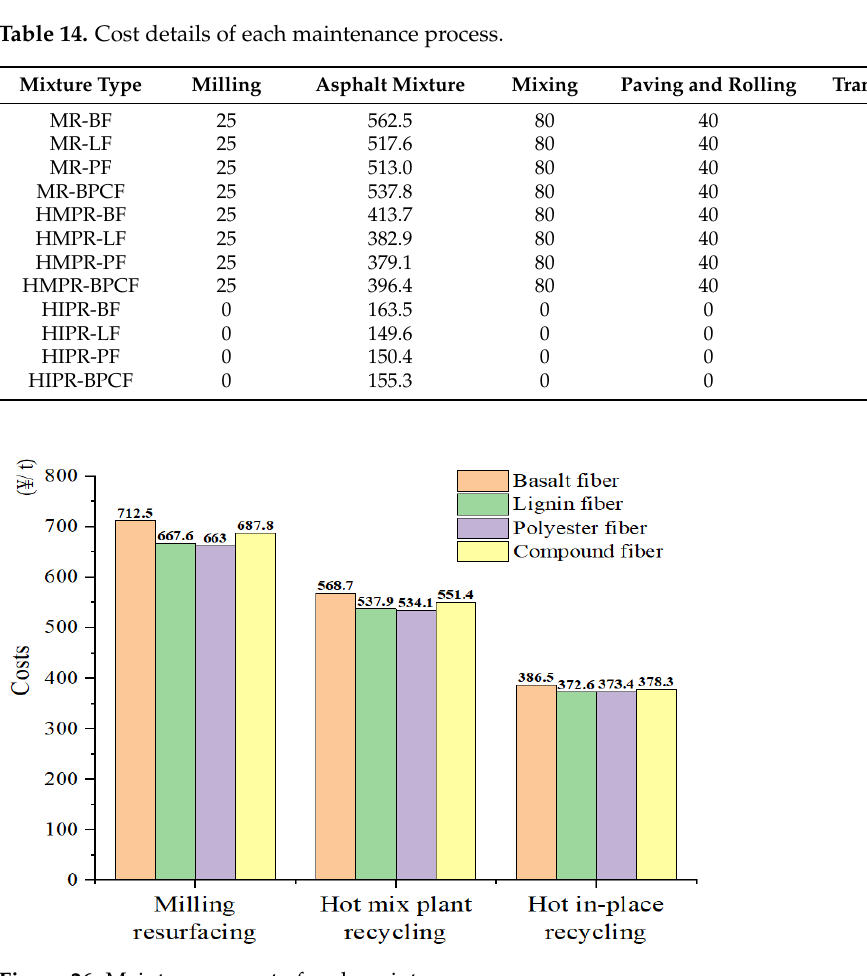
Figure 26. Maintenance cost of each maintenance